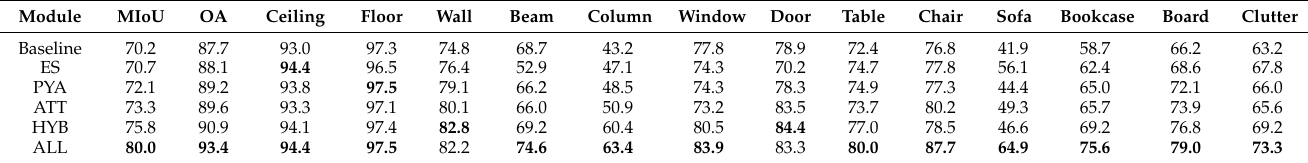
Table 4. Statistical results of evaluation indicators of each module (%). The best results are presented in bold.